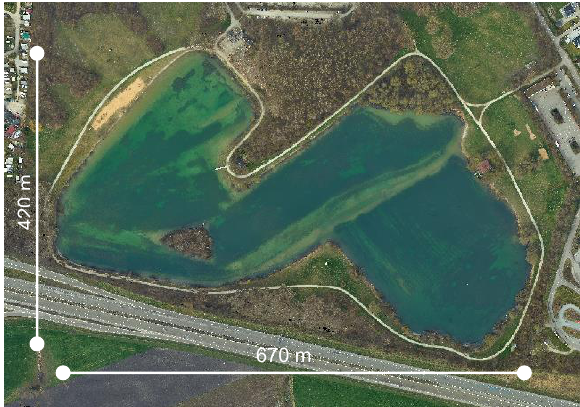
Figure 2. Block layout with control points (yellow) and extracted point cloud (screenshot Pix4